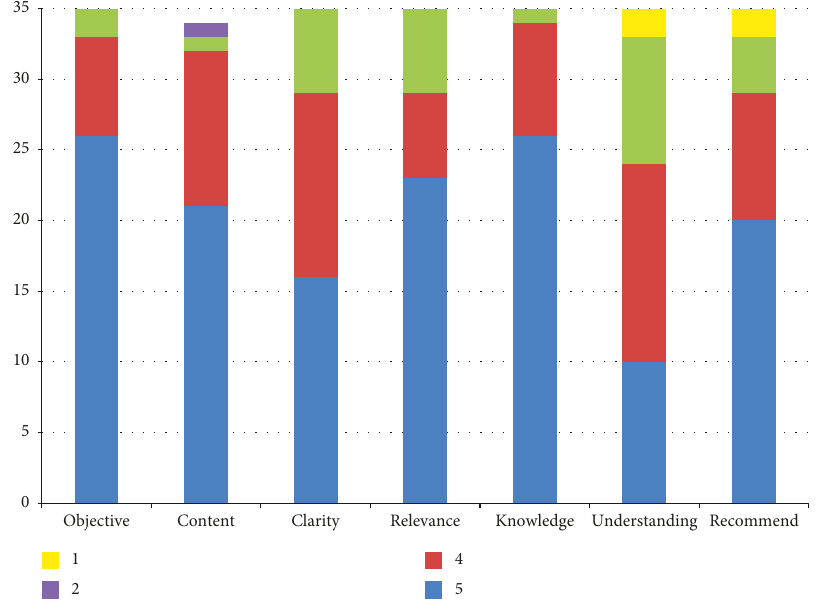
Figure 3: Students’ rating of the course. Students rated the course based on the objectives, content, clarity, relevance, knowledge, understanding, and